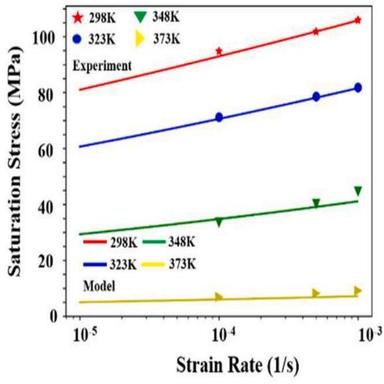
Comparison of the predicted saturated stress value of the modified underfill with the actual value.